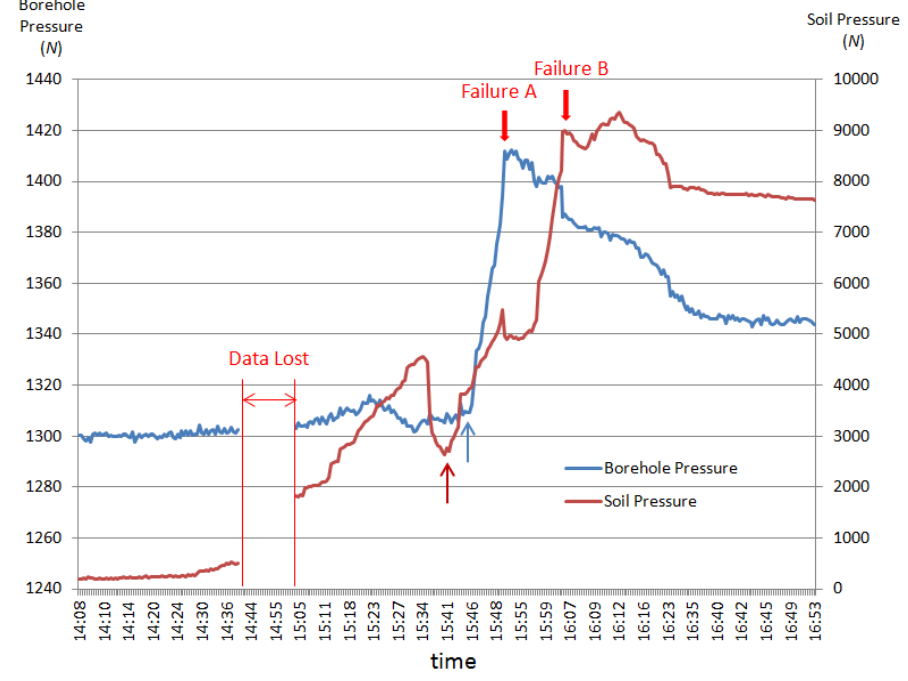
Figure 10. Monitoring result of the borehole pressure gauge and the soil pressure